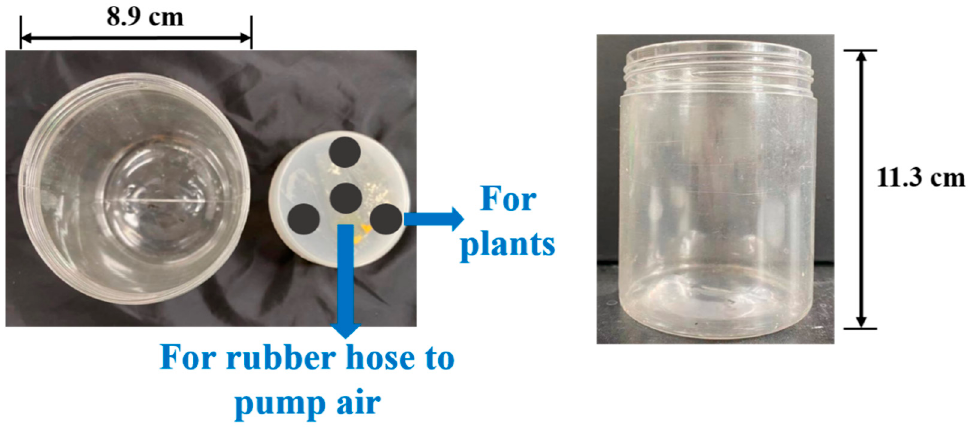
Figure 1. The container and lid retrofitted for the hydroponic system. Side holes were punched for the plants; the central hole was punched for a rubber hose linked to the air pump.